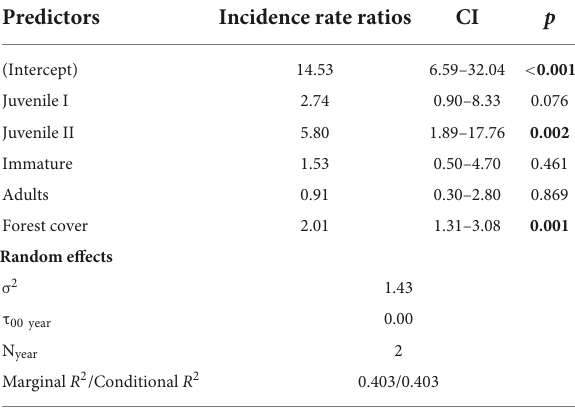
TABLE 2 Top-ranked Generalized Linear Mixed Model coefficients explaining the relationship between Euterpe edulis abundance, its ontogenetic stage and forest cover at landscape scale within 800 m radius